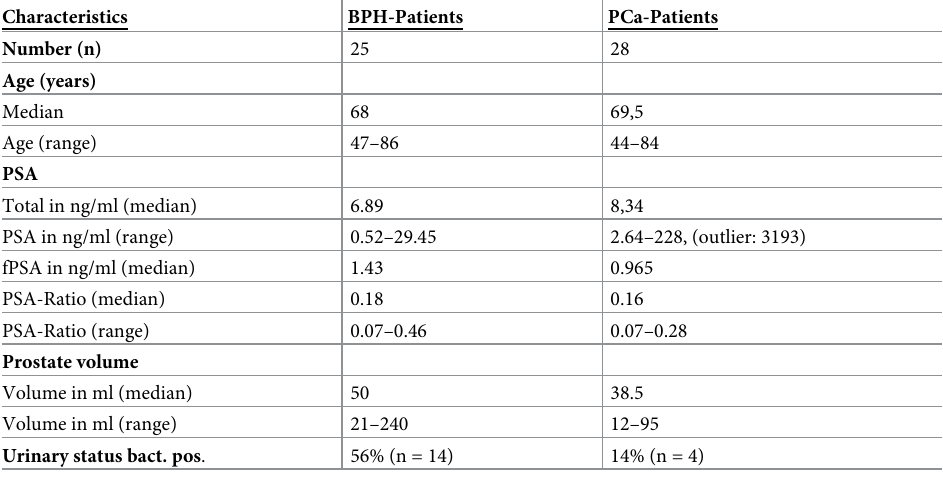
Table 1. Clinical data of the study